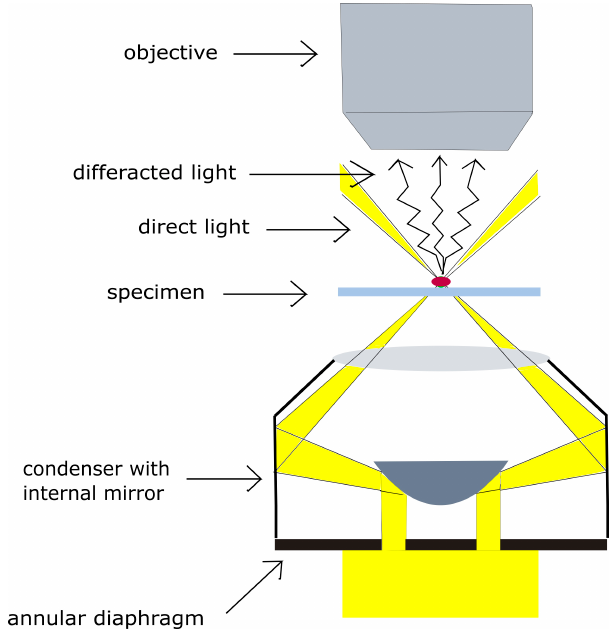
Figure 1. Scheme of nanoparticle illustration under CytoViva enhanced dark-field microscope with a hollow cone condenser. Only diffracted rays are collected by the objective.